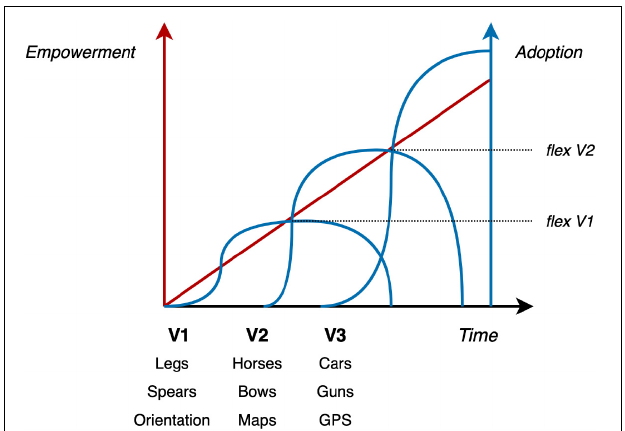
FIGURE 5 | Waves of technological adoption related to predictive slopes of extended engagement (empowerment) during versioning of the technology. Indeed this is an oversimplification for the sake of visualization as we are assuming a linear progression of empowerment over time in the evolving versions of the technology (i.e., a healthy research and development cycle) where, for most technologies, newer versions may not present much greater empowerment as compared to older ones. The important idea here is the inflection point (flex) indicating the start of technological decay reflecting the abandon rate of a practice as the experience of better predictive slopes of extended technological engagements lead to disengagement of non-extended approaches (e.g., cars replace horses replacing legs). Old slopes are less than expected and so unsatisfactory as compared to new ones.